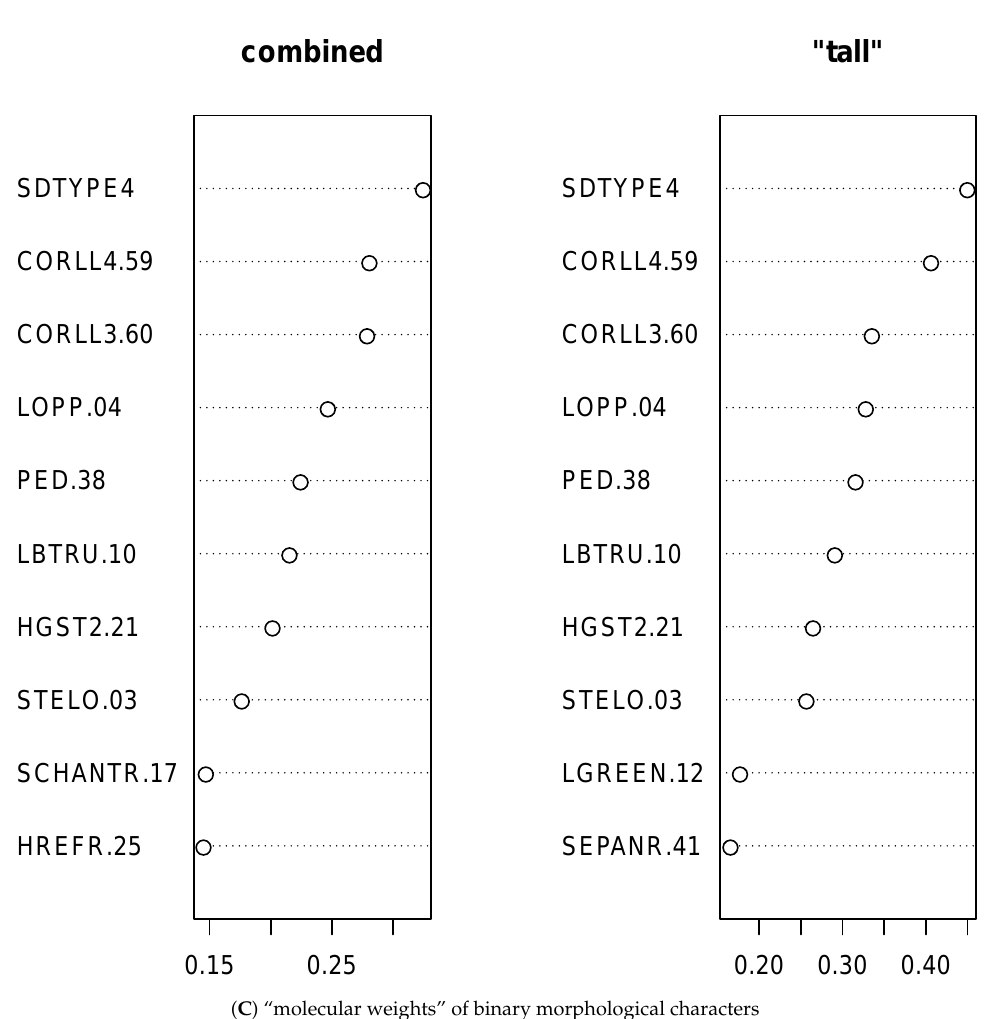
LBTRU.10PED.38LOPP.04CORLL3.60CORLL4.59SDTYPE4 HREFR.25SCHANTR.17STELO.03HGST2.21 Figure 9. Morphological characters in Plantago : ( A ) explanation of morphometric measurements, character abbreviations are: PET.L petiole, LEAF.L leaf, SPIKE spike, and STALK scape lengths, LEAF.W maximal leaf width, TAPROOT presence of taproot, and GAP presence of gaps in the inflorescence; ( B ) “molecular weights” (median and maximum average Spearman correlations on 1000 bootstrap replicates) of morphometric characters, character abbreviations are the same; ( C ) “molecular weights” (average correlations between tree data and combined data) of binary characters, character abbreviations are explained in the Table S3. White dots are data